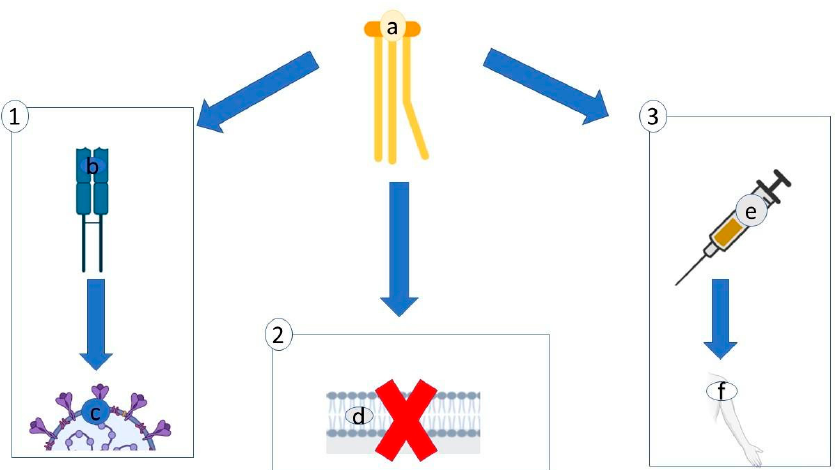
Figure 5. Three potential effects of fatty acids ( a ) against SARS-CoV-2: (1) FA could increase T cells ( b ) that target the spike proteins ( c ); (2) FA penetrates the lipid membrane of the virus, destabilizing the envelope’s architecture ( d ); (3) FA could help to prevent collateral effects in vaccinated people ( e – f ).